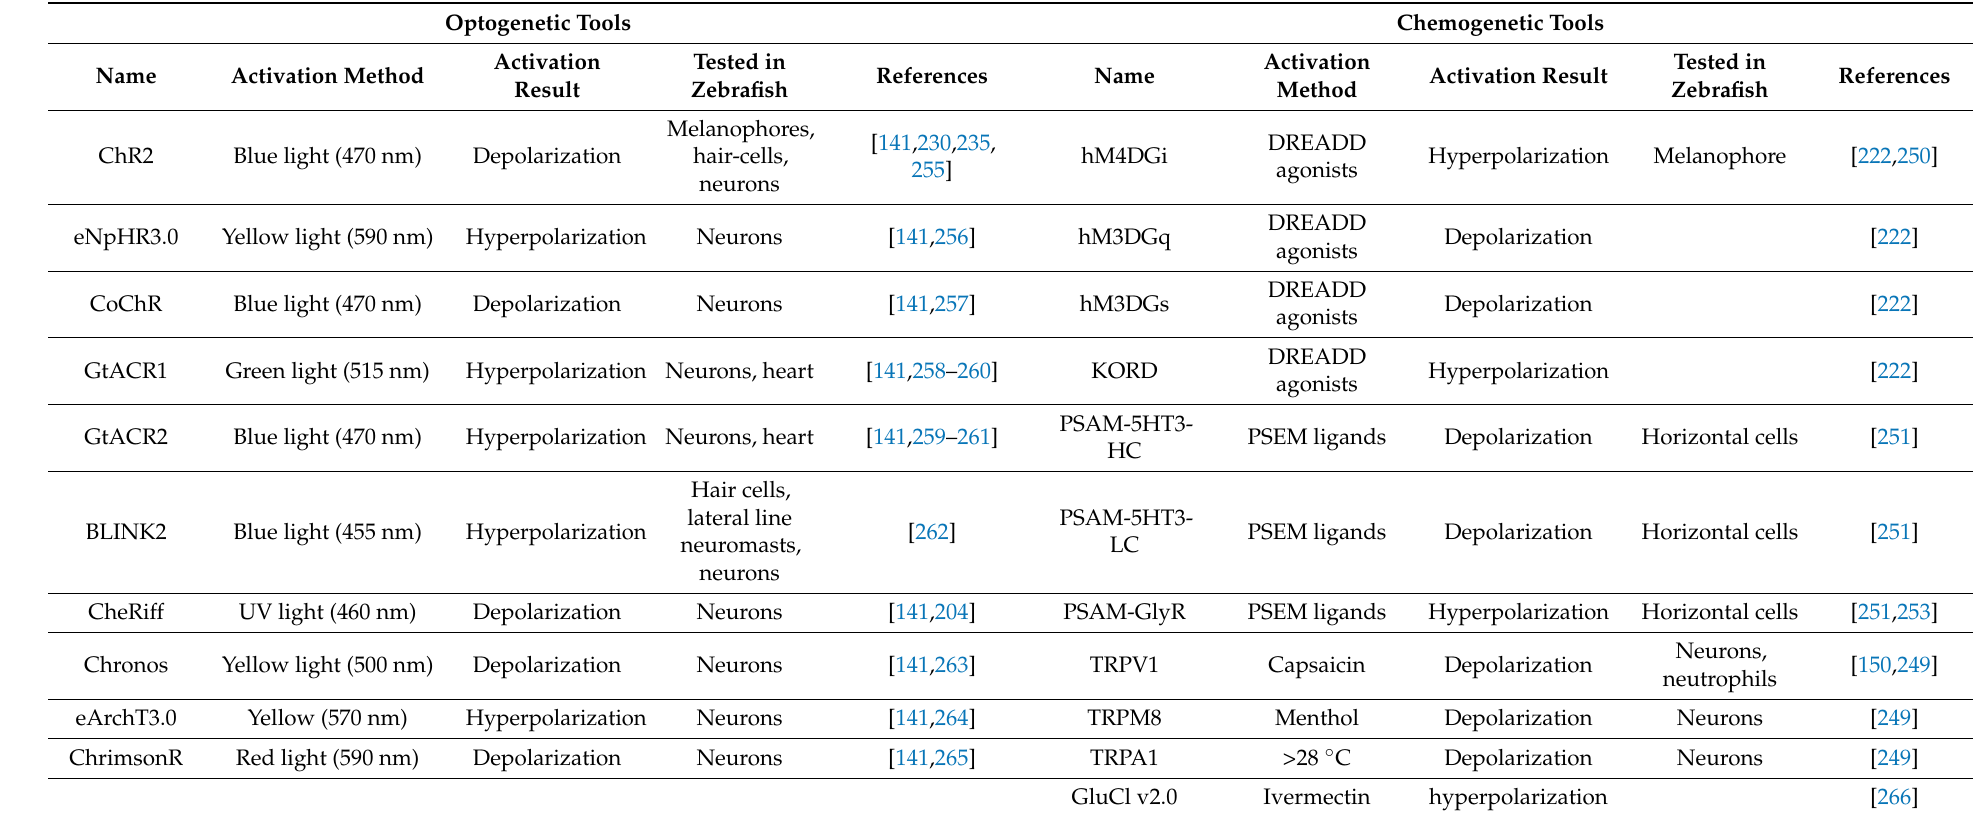
Table 4. Common optogenetic and chemogenetic